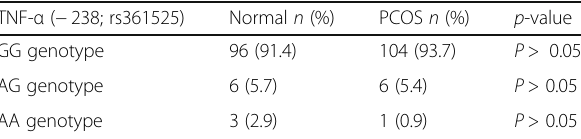
Table 2 Distribution of Genotypes and Allele Frequencies of